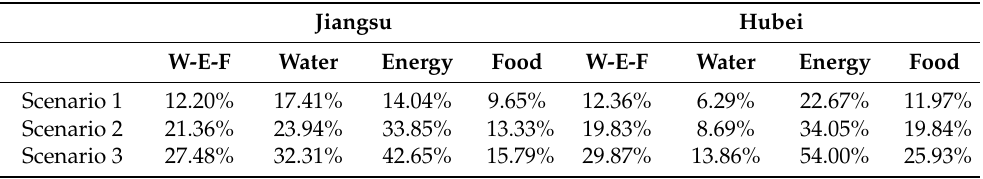
Table 7. Change rate of system security value under each